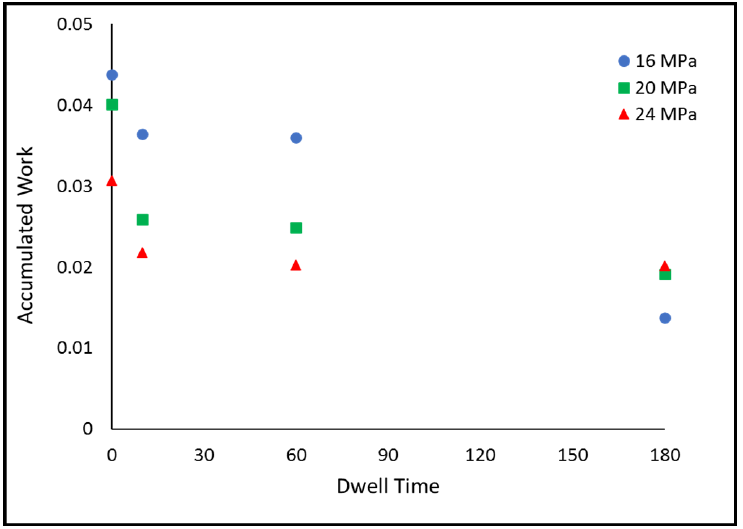
Figure 23. Accumulated work until complete failure vs. dwell time at different stress amplitudes.